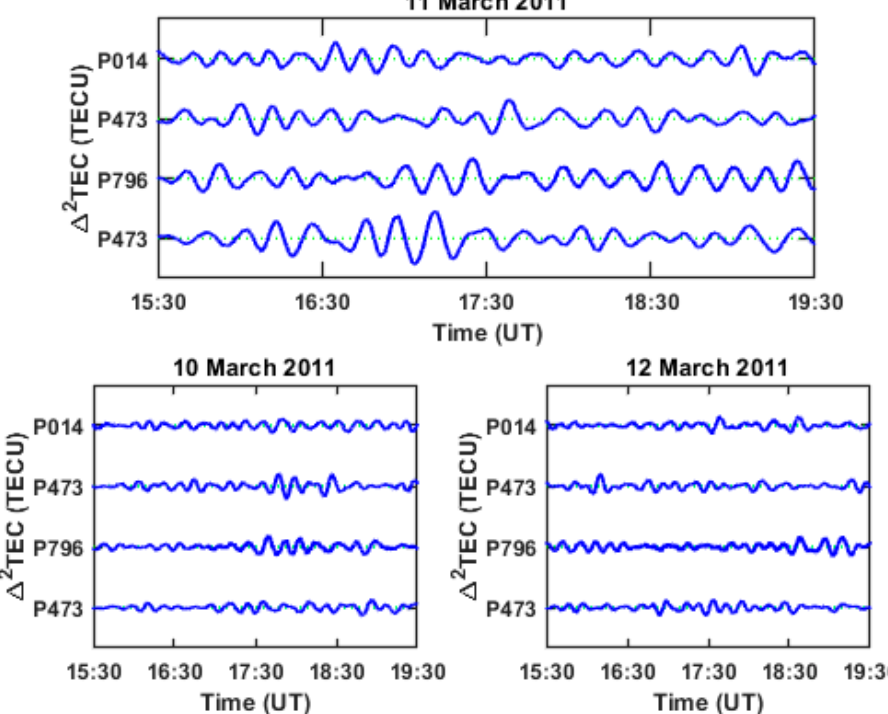
Figure 19. ∆ 2 TEC time series of PRN18 observed from four GPS stations on 10, 11, and 12 March 2011. Results from each station are vertically shifted from the previous station by 1.5 TECU.